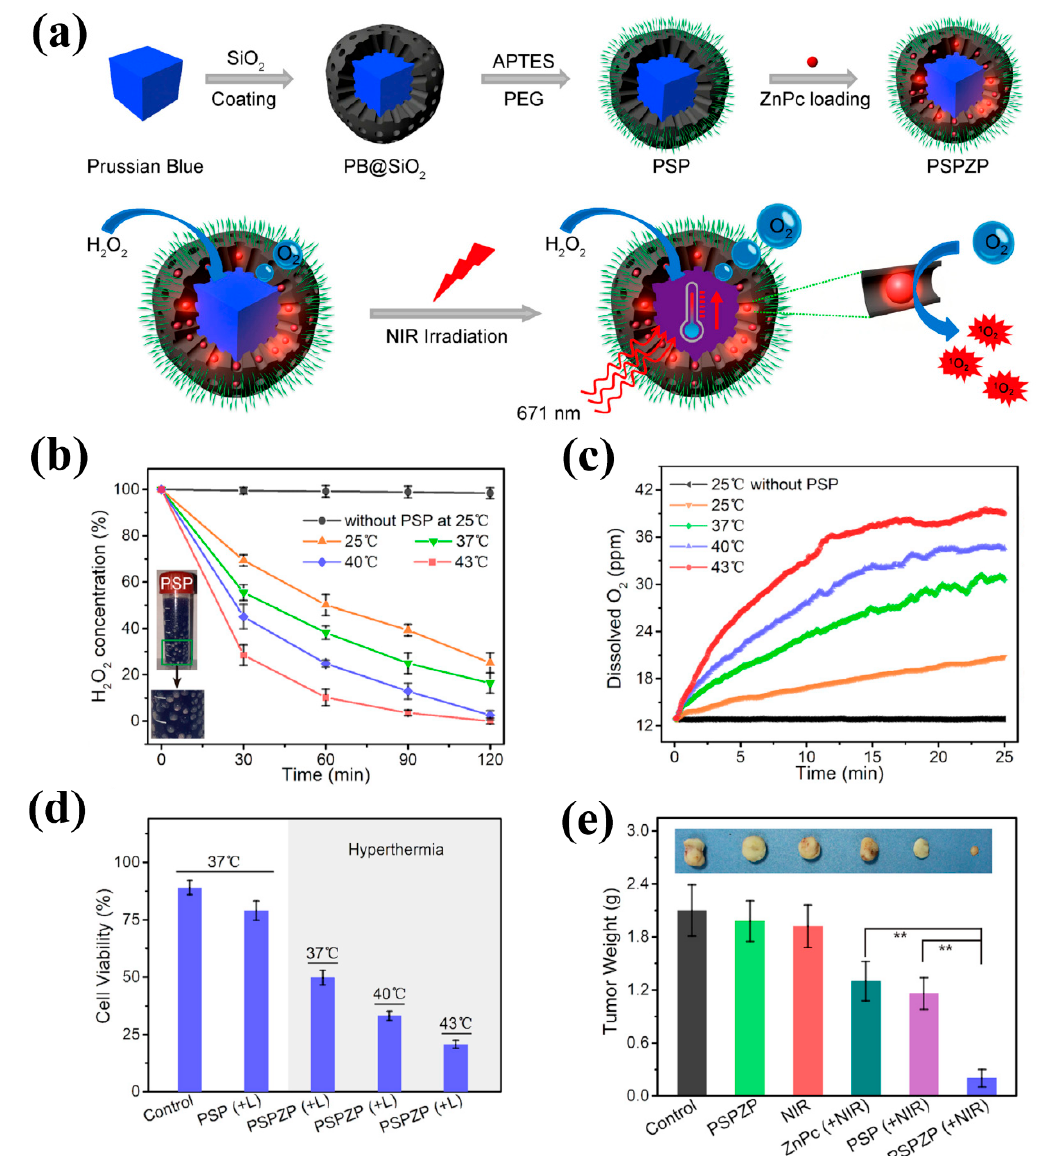
Figure 4. ( a ) Schematic of the synthetic procedure and photo-enhanced therapy of the PSP NCs; ( b ) Decomposition of H 2 O 2 and ( c ) O 2 generation treated with PSP NCs or not treated; ( d ) Relative viabilities of 4T1 cells incubated with PSP or PSPZP NCs; ( e ) Average weights of tumors collected from mice at the end of treatments, adapted with permission from ref. [100]. ** p